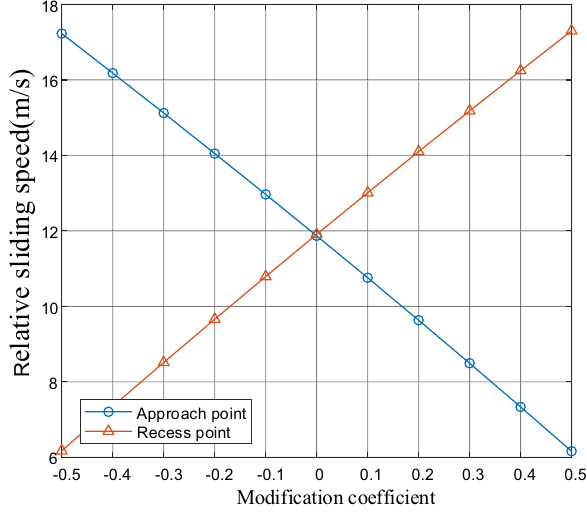
Fig. 15 Influence of modification coefficient on relative sliding speed